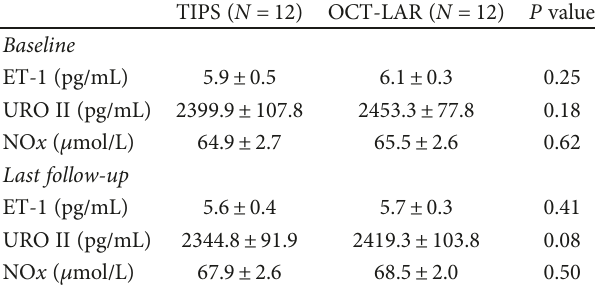
Table 2: Hemodynamic values at baseline and last follow-up. OCT-LAR ( N = 12 ) Baseline Last follow-up